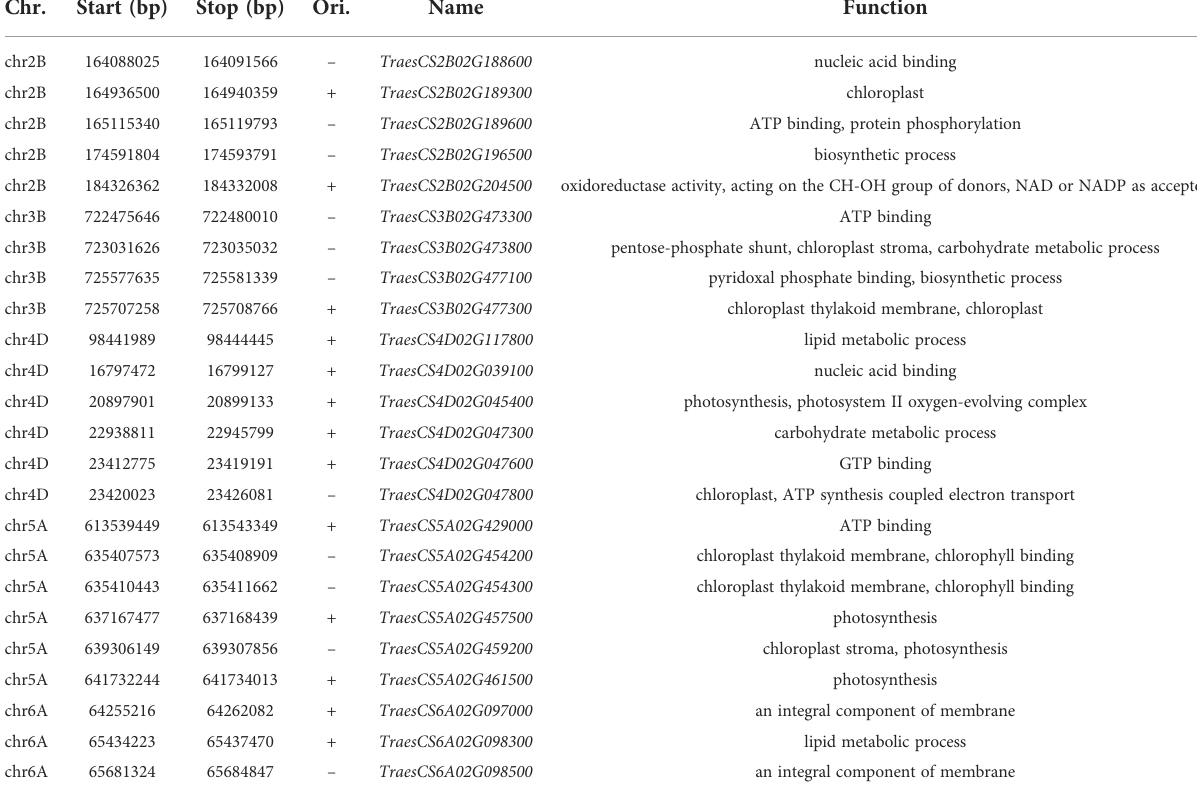
TABLE 5 Function genes related to chlorophyll and phosphorus, which highly expressed in leaves. Chr.